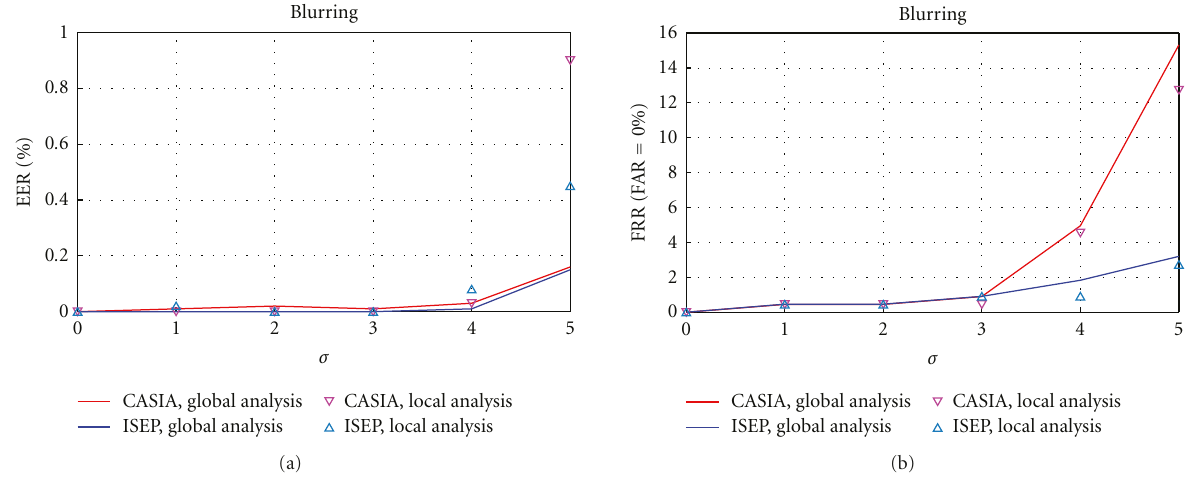
Figure 19: (a) EER and (b) FRR (FAR = 0%) as a function of the standard deviation of the blurring Gaussian filter, measured on CASIA and ISEP databases.